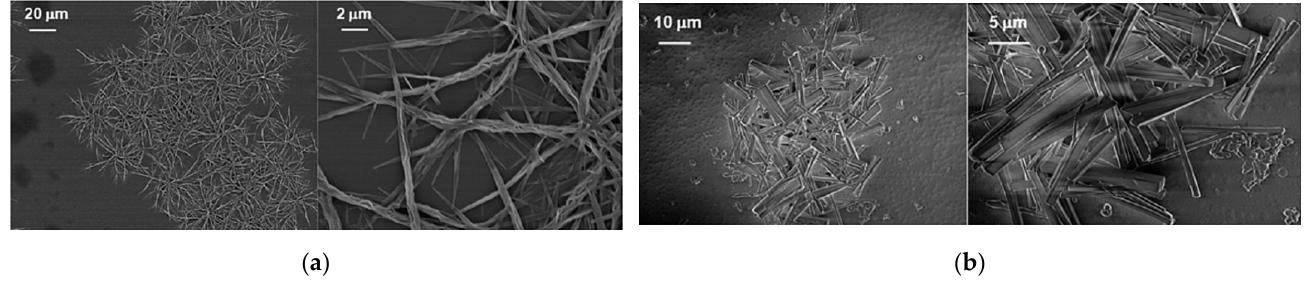
Figure 15. ( a ) SEM micrographs of an air-dried suspension of self-assembled NIP-3T amphi . ( b ) SEM micrographs of an air-dried suspension of self-assembled NIP-3T lipo . Reproduced from [31] with permission from the PCCP Owner Societies.